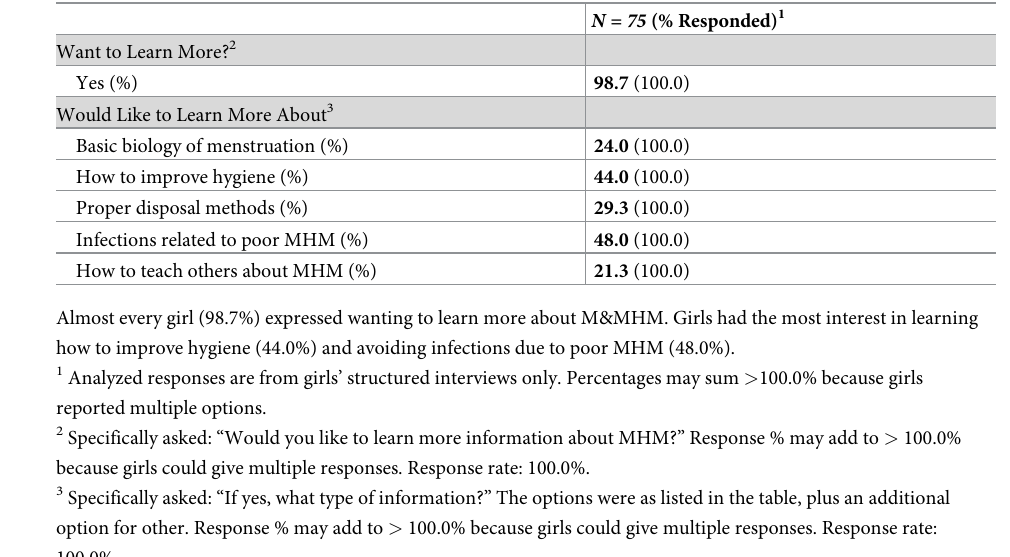
Table 7. Girls’ interests in learning more about